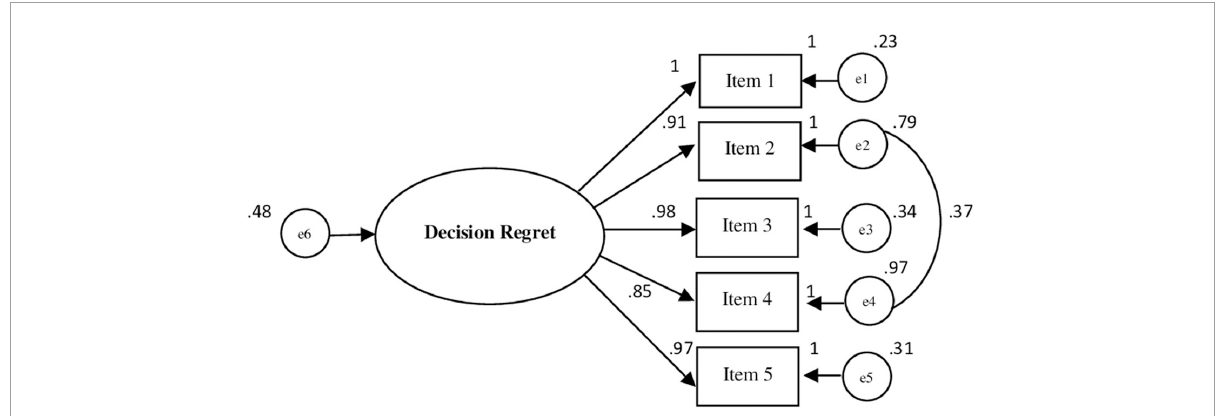
FIGURE1 Path diagram of the confirmatory factor analysis (5 items). Chi-square = 6.019; χ 2 df = 1.506; CFI = 0.999; TLI = 0.997; RMSEA = 0.024 and RMSEA 90% CI [0.00–0.051].